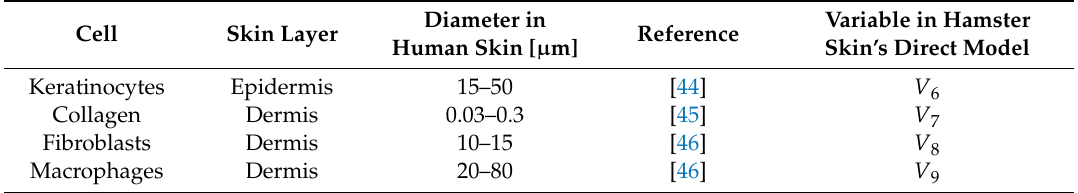
Table 2. Diameter of cells in human skin and related variable in the Hamster Skin’s Direct Model. Cell Skin Layer